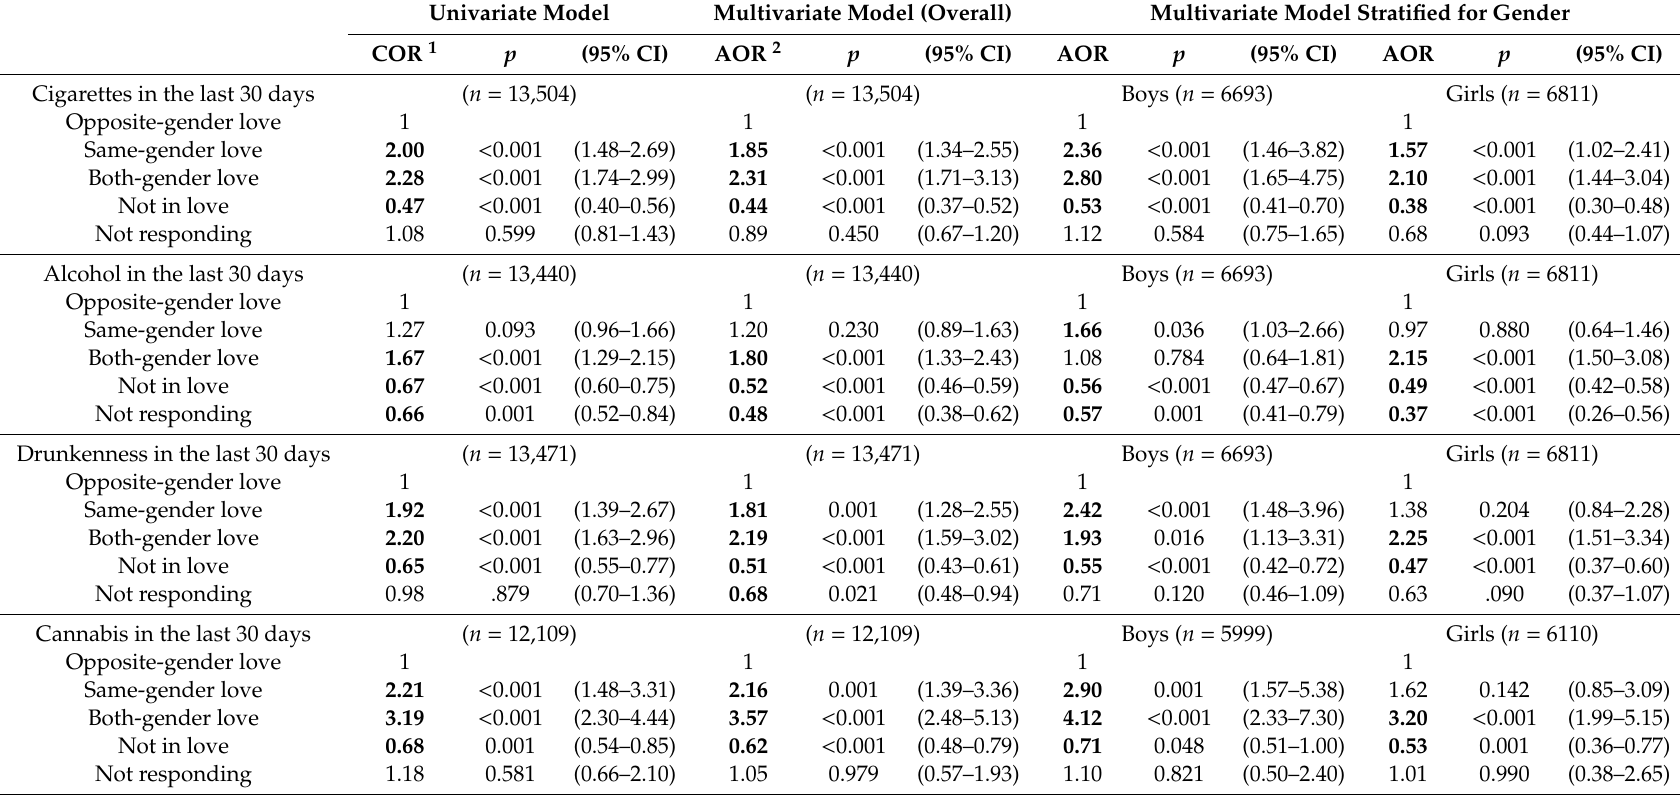
Table 3. Crude and adjusted odds for the four types of substance use, overall and by gender. Univariate Model Multivariate Model (Overall) Multivariate Model Stratified for